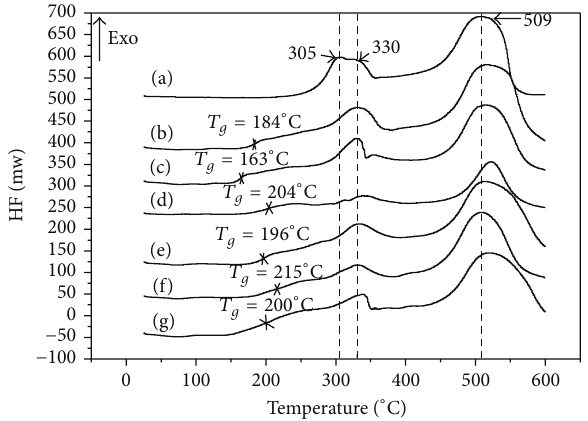
Figure 6: DTA curves of MR resin (a), MR-EDA resin (b), MR- DETA resin (c), MR-TETA resin (d), MR-EDA-TCEP resin (e), MR- DETA-TCEP resin (f), and MR-TETA-TCEP resin (g) heated with the temperature increment rate 5 ∘ C min −1 in air.